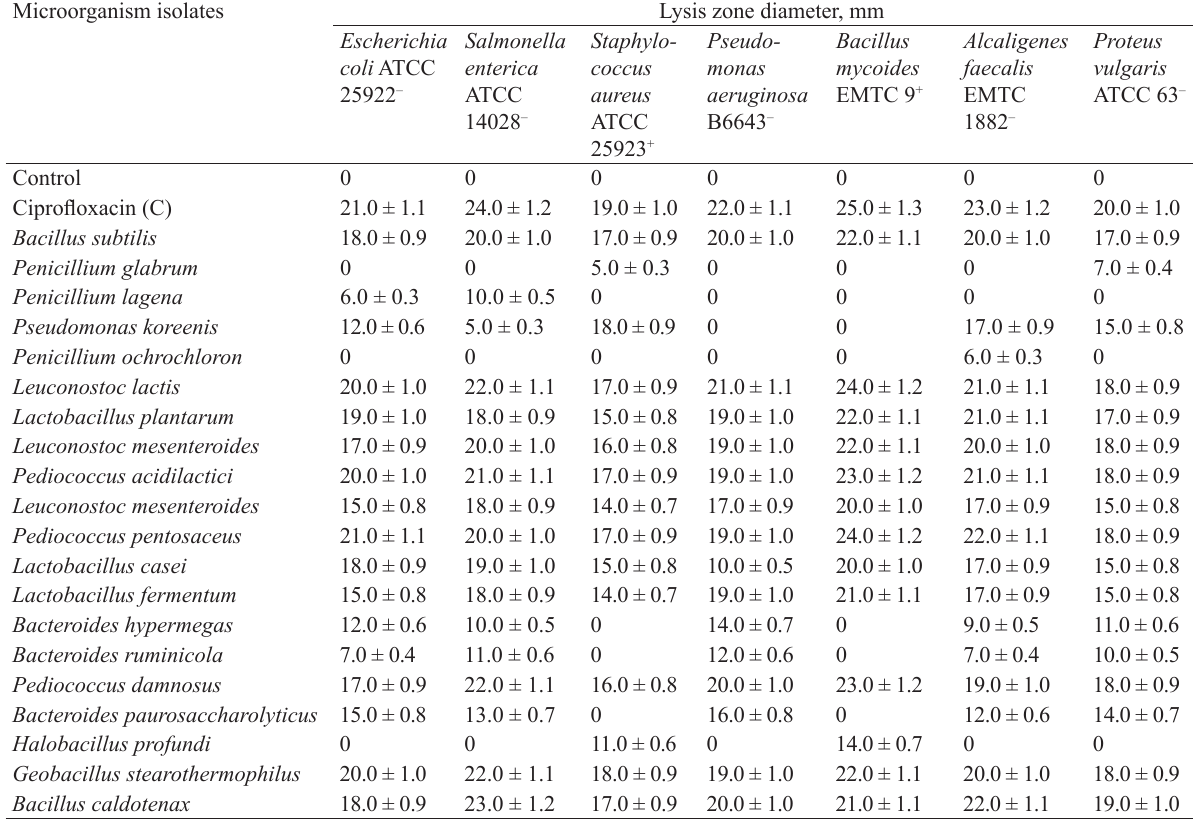
Table 1 Antimicrobial activity of natural microorganism isolates by the diffusion method (solid nutrient medium) Microorganism